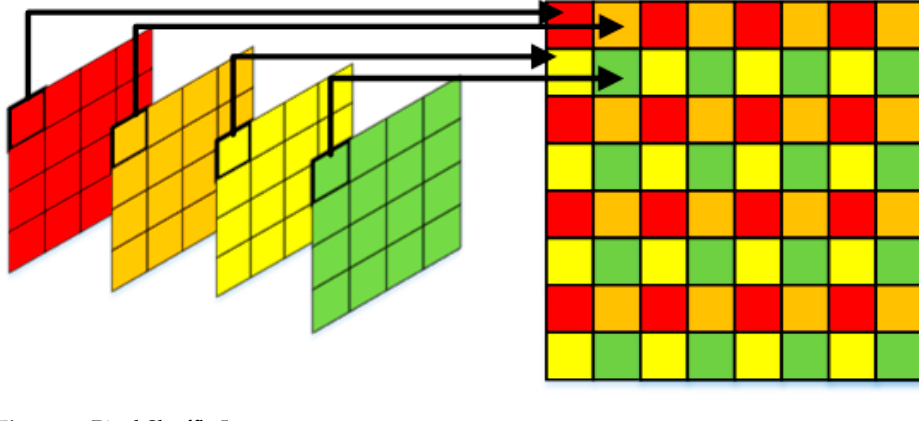
Figure 3. Pixel Shuffle